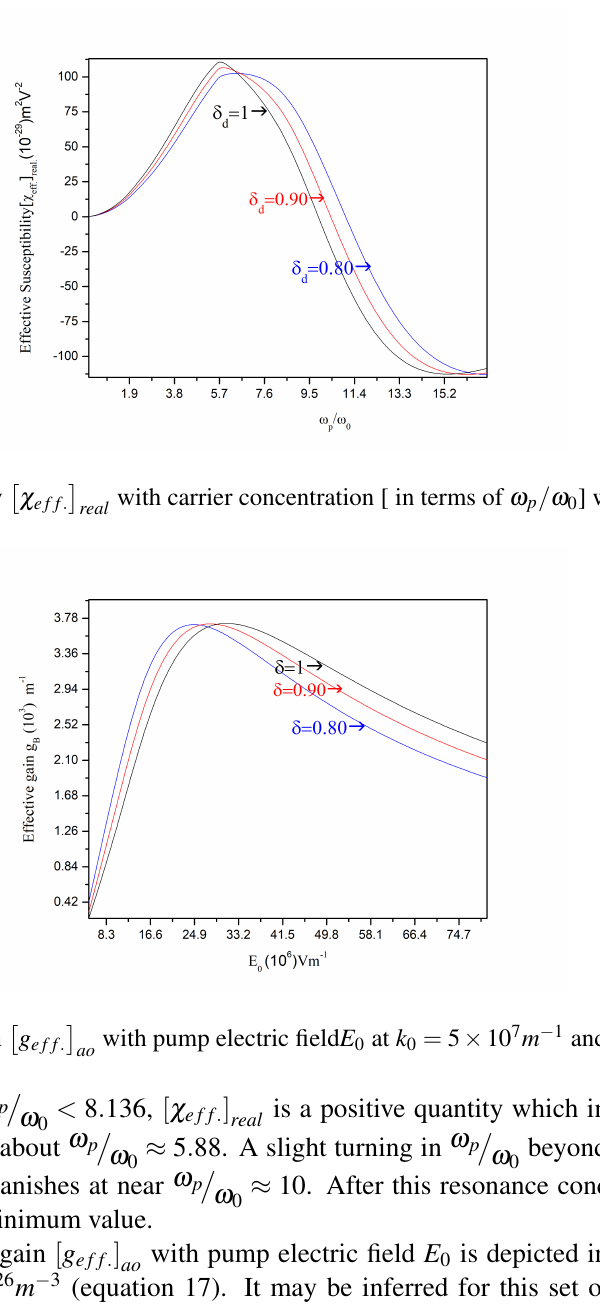
Fig. 3 Effective gain